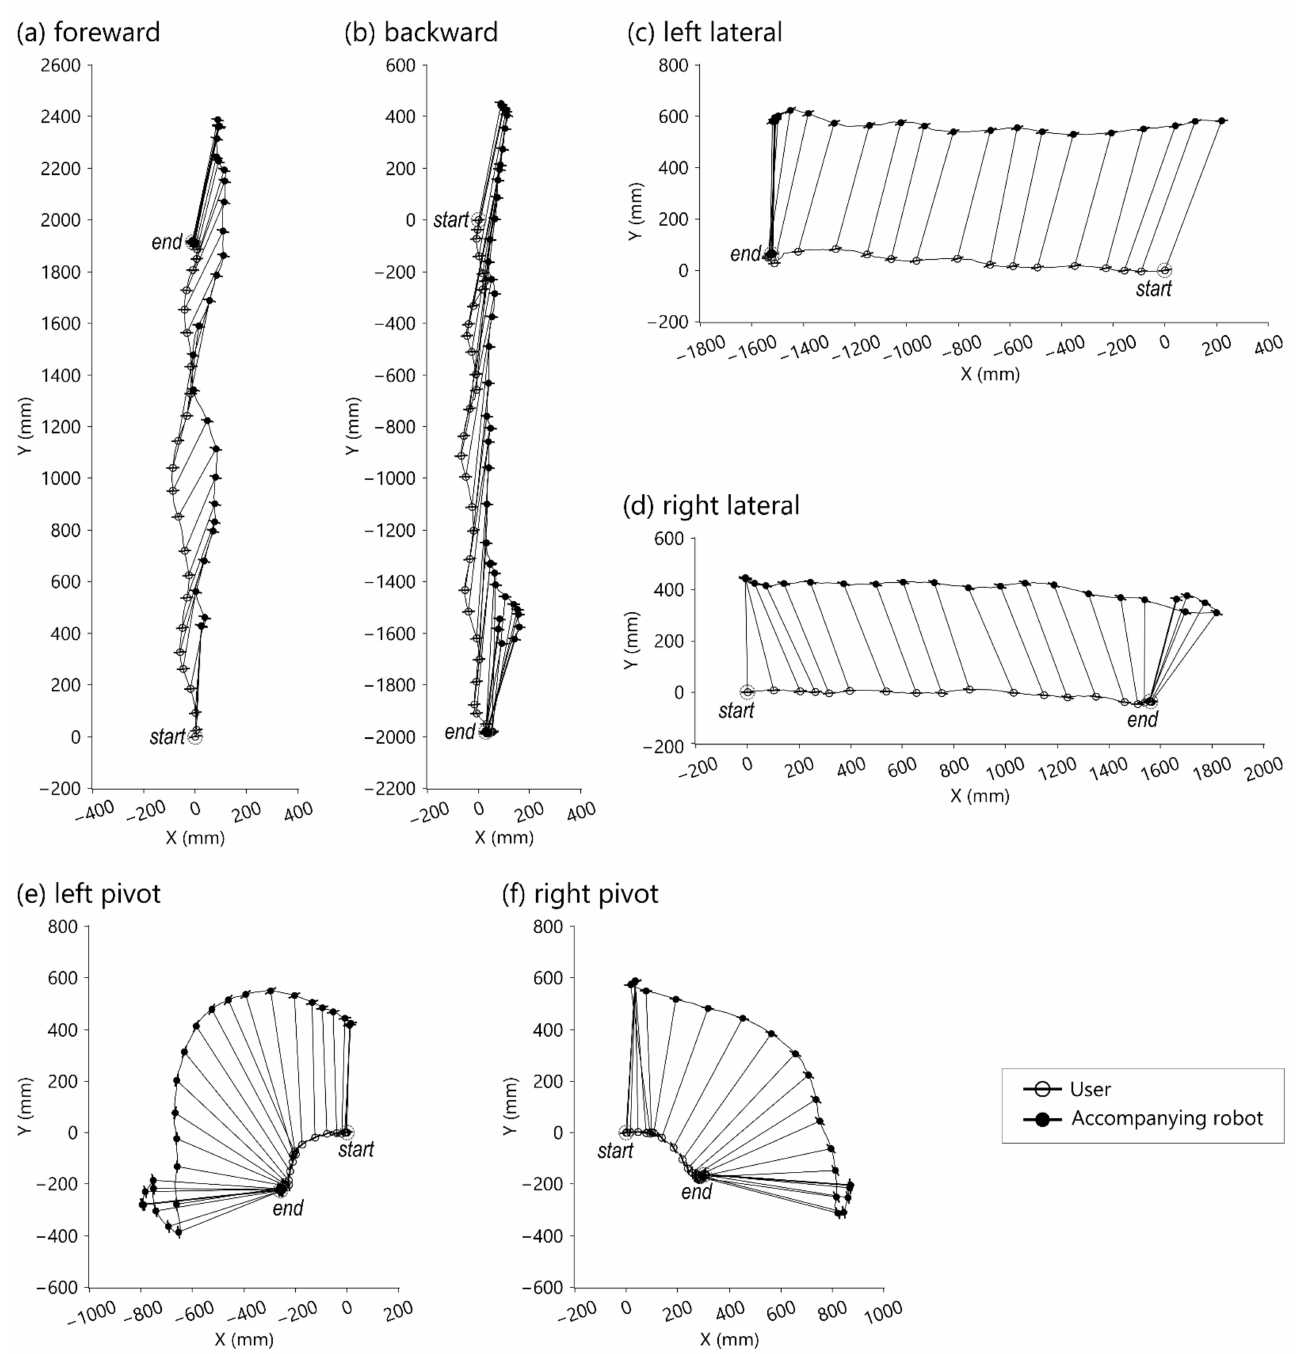
Figure 6. Top-view motion graph of the movements of the robot and user w.r.t. the WCS. ( a ) Forward walking test; ( b ) backward walking test; ( c ) left lateral walking test; ( d ) right lateral walking test; ( e ) walking test with pivot turning to the left; ( f ) walking test with pivot turning to the